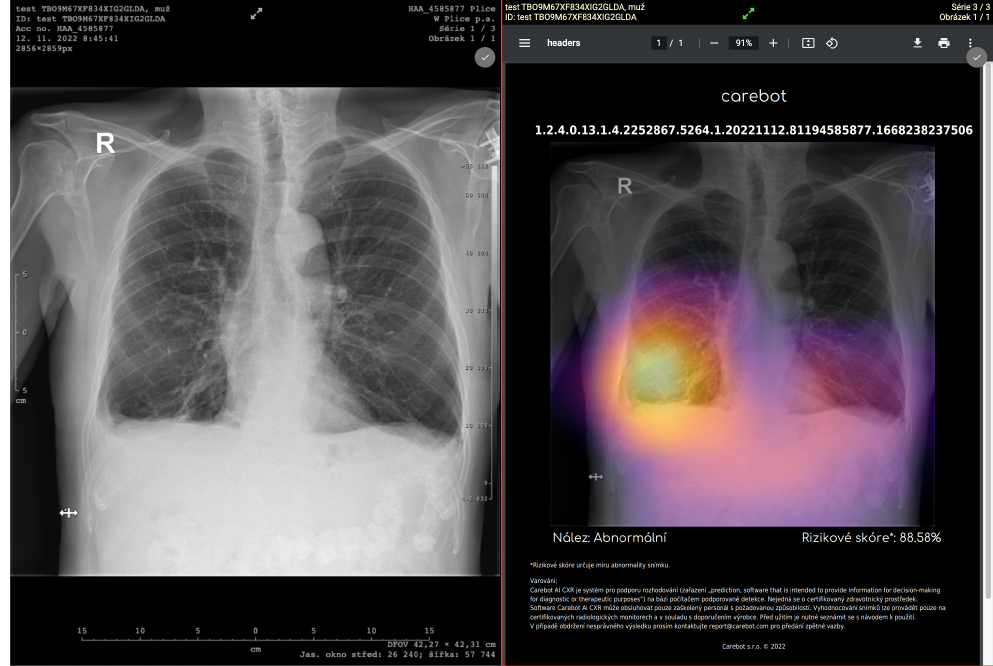
Figure 3. User interface of DLAD software implemented in PACS (CloudPACS by